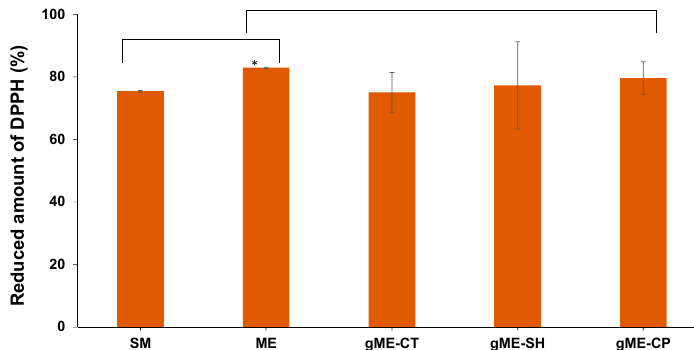
Figure 5. Reduced amount of DPPH, for CURC encapsulated in various microemulsion systems (at 1% concentration) and reference solvent mixtures (sample denoted in Table 1) determined at equilibrium (time = 900 s). (*) statisticaly significant ( p < 0.05).